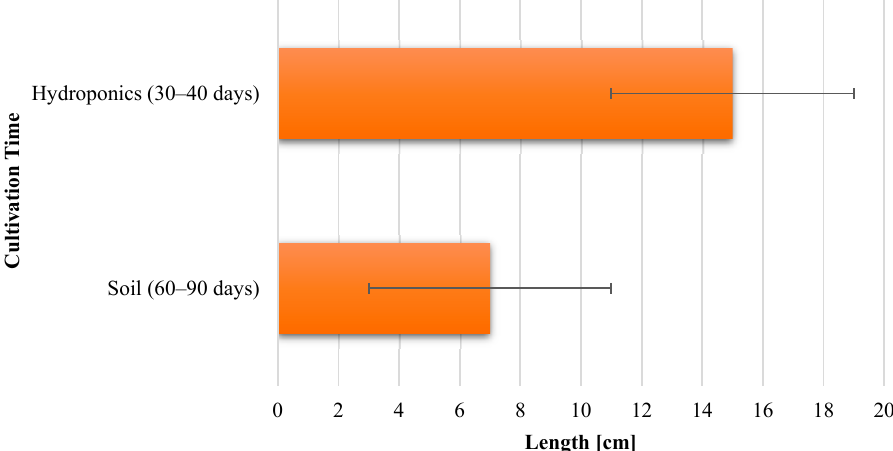
Figure 14. Length of fully-grown lettuce leaves in cm. A periodic plot of the leaf length of romaine lettuce grown in soil as well as in hydro- ponics is depicted in Figure 15. The x-axis is labeled as the number of days from sowing the plant in a periodic interval of 10 days, and the y-axis is labeled as the leaf length in cm. This depiction clarifies the rate of growth of a leaf in both mediums at an interval of 10 days from the day of sowing. Another inference that can be derived from this plot is that in addition to taking less time to grow fully, the pace of growth of a hydroponic lettuce leaf is double that of the leaf grown in soil.